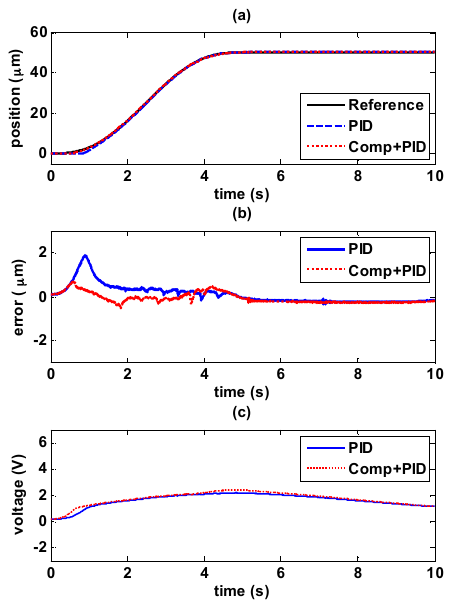
17 of 20 Figure 20. Tracking control comparisons of sinusoidal trajectory with 1 Hz frequency and 50 μ m amplitude between using MFSMC path controller solely and MFSMC path controller with the hysteresis compensator: ( a ) path tracking responses; ( b ) control errors; ( c ) control signals. It is evident that higher frequency signals have larger errors. In Figure 19b, the maximum error